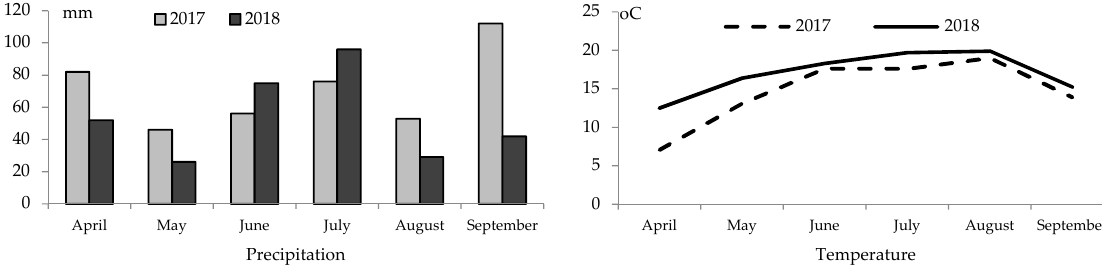
Figure 1. Precipitation and air temperatures in 2017–2018 according to IMiGW PIB (Institute of Meteorology and Water Management, National Research Institute), Warsaw, Poland.